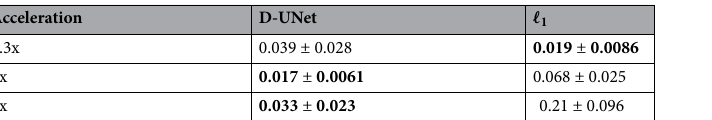
Table 1. Total mean squared error (MSE) over 100 testing spectra for each acceleration factor. A D-UNet model was trained to learn reconstruction for each sampling factor, and the results were compared to ℓ 1 -norm reconstruction as described in Eq. (3). Since the maximum signal is 1 for all spectra analyzed, the normalized MSE as a percentage for the D-UNet is 3.9%, 1.7%, and 3.3% for acceleration factors of 1.3x, 2x, and 4x, respectively. Similarly, the MSE as a percentage for the ℓ 1 -norm reconstruction is 1.9%, 6.8%, and 21% for acceleration factors of 1.3x, 2x, and 4x,